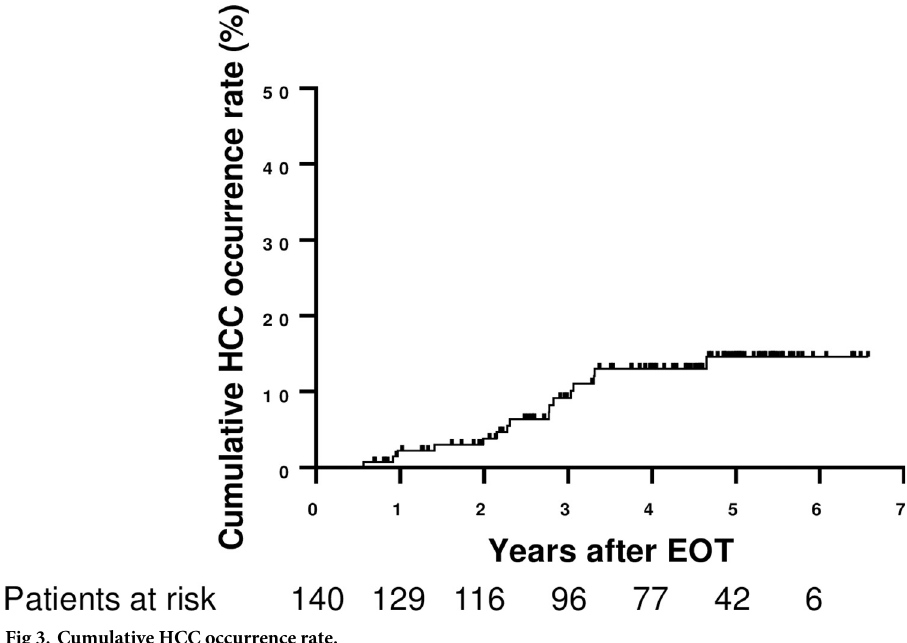
Fig 3. Cumulative HCC occurrence